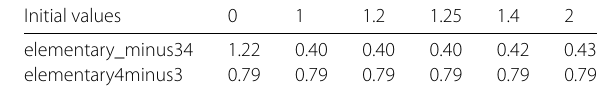
Table 5 Numerical Platen convergence rates, based on step sizes 2 – ˜ n , ˜ n ∈ { 4, ... ,10